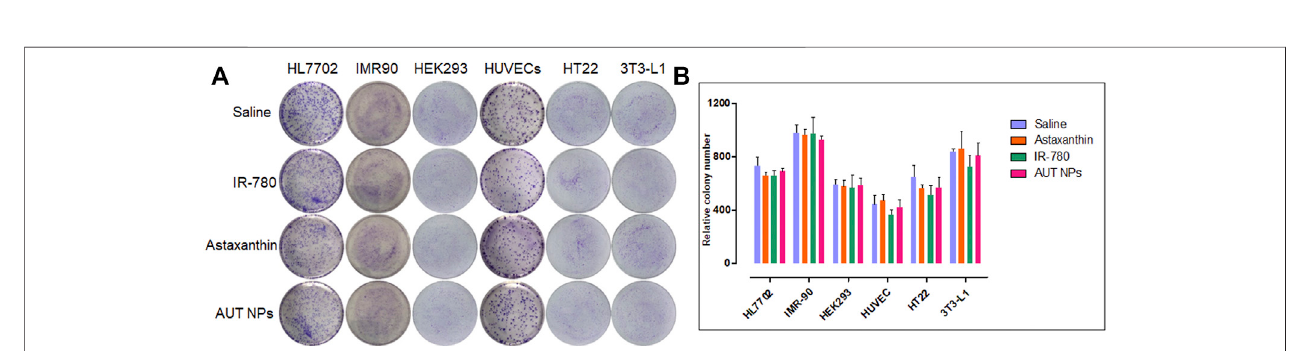
FIGURE 4 | The colony formation assay results of AUT NPs and their ingredients in different cell lines. The colony photographs throughout the assay (A) and the quantitative analysis result (B) .